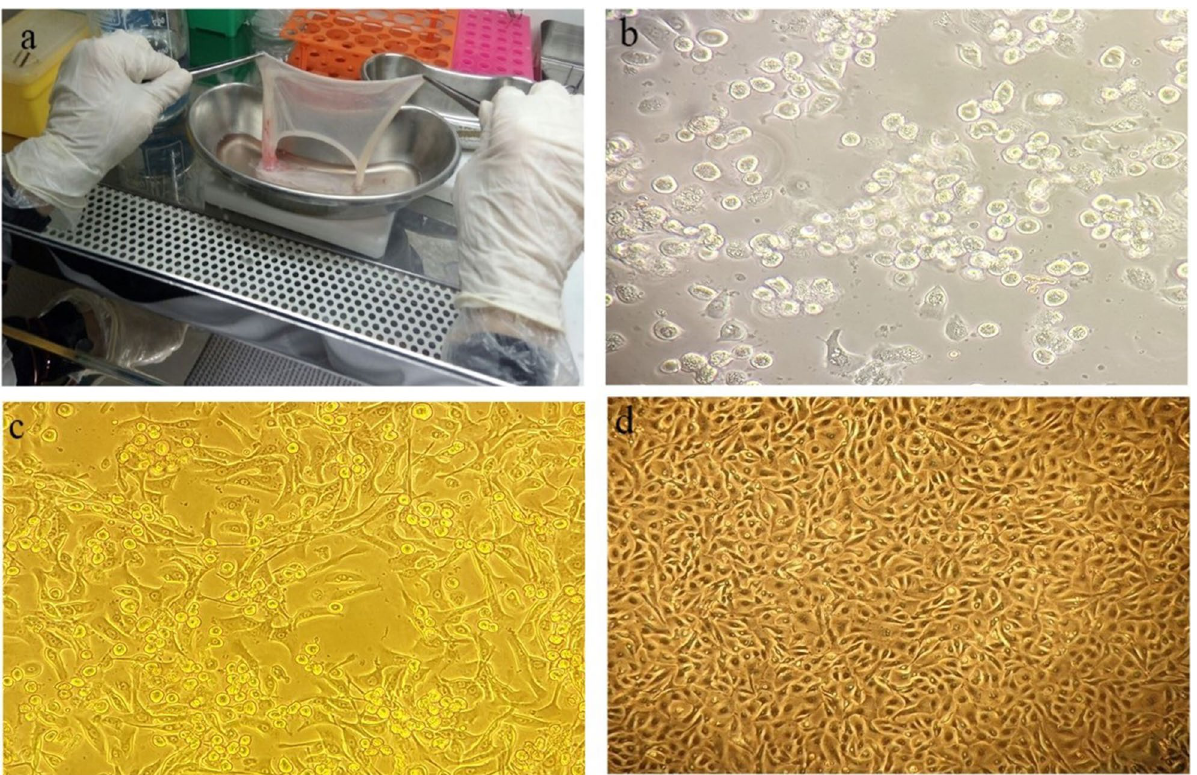
Figure 2. Isolation of hAECs. ( a ) An amniotic membrane is provided from the human placenta under sterile conditions. ( b ) hAECs immediately after isolation on day zero. ( c ) hAECs three days after culture under standard conditions. ( d ) hAECs ultimately reached confluency.